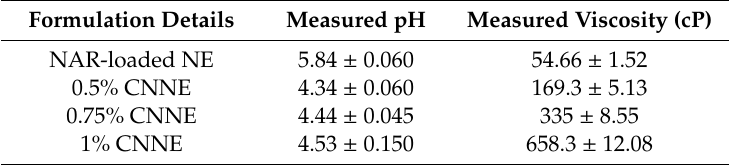
Table 6. Representation of pH and viscosity of the nanoemulsion (NE)